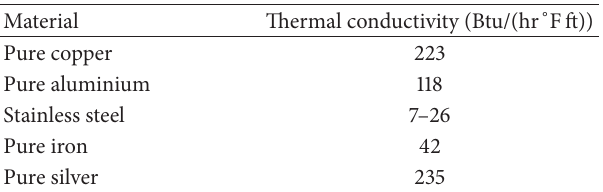
Table 2: Thermal conductivity of some metals at 68 ∘ F (20 ∘ C) [4].